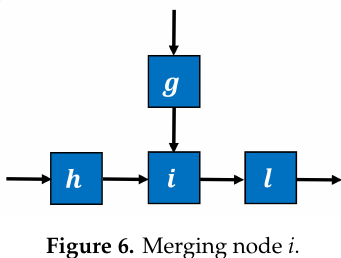
Figure 6. Merging node i .